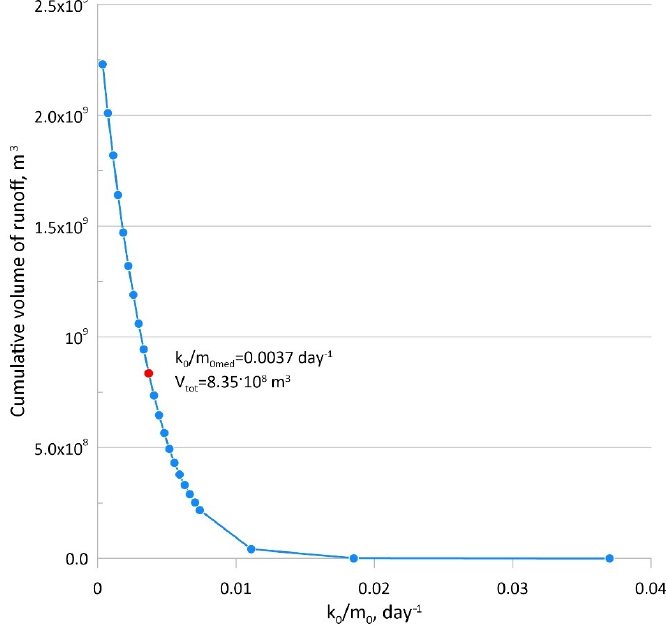
Figure 15. Dependence of the simulated cumulative volume of river runoff at the Dongjuyanhai gauging station on the average k 0 /m 0 of riverbed sediments. The red dot represents the median calibrated k 0 /m 0 and the simulated volume of runoff.